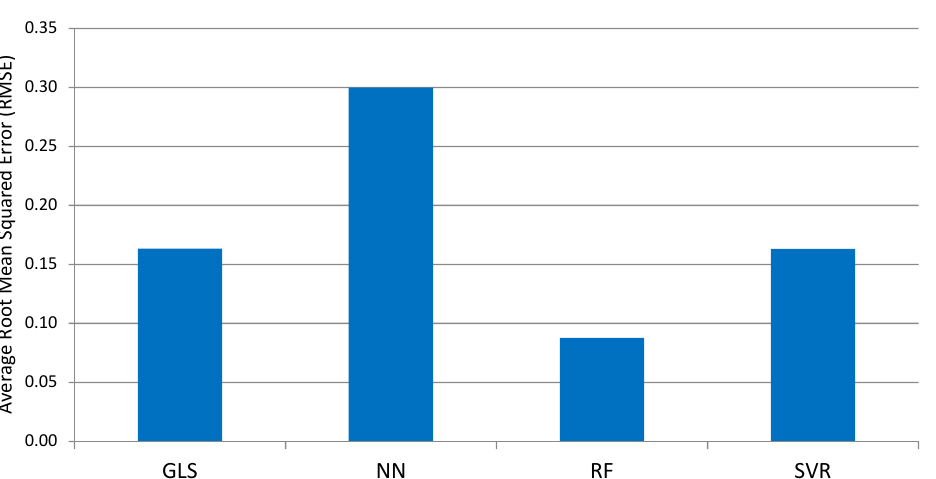
Figure 19. Scatter plot comparing the actual and predicted MPI of 2017 (obtained from four ma- chine-learning algorithms). Source: Calculation and graphics generated by authors.